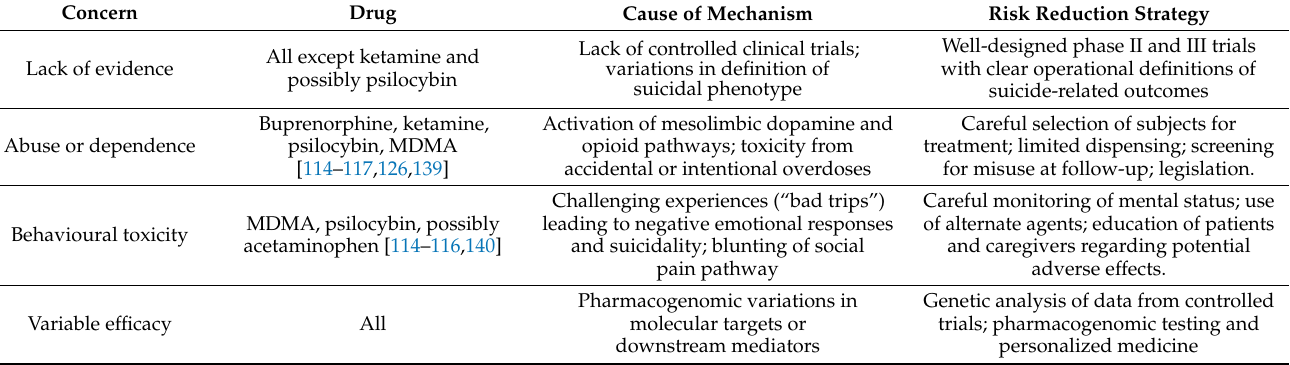
Table 2. Limitations and safety concerns associated with novel pharmacological strategies for suicide